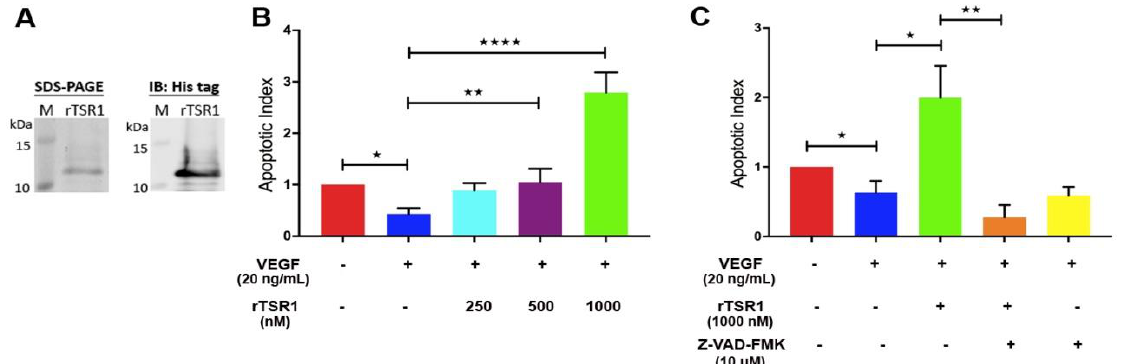
Figure 1 . Recombinant type 1 repeat domain (rTSR1) induces caspase-dependent apoptosis in human umbilical vein endothelial cells (HUVECs). ( A ) SDS-PAGE and immunoblot analysis of purified rTSR1 showed a band at ~10 kDa; ( B ) rTSR1 dose-dependently induced apoptosis in HUVECs in the presence of VEGF. Data shown are apoptosis observed at 24 h post-1000 nM rTSR1 treatment; ( C ) Pan-caspase inhibitor (Z-VAD-FMK) significantly reduced the 1000 nM rTSR1-induced apoptosis at 24 h post treatment. Data represent the mean of triplicates ± SD. Statistical analysis performed by one-way ANOVA. * p < 0.05, ** p < 0.01, **** p < 0.0001.